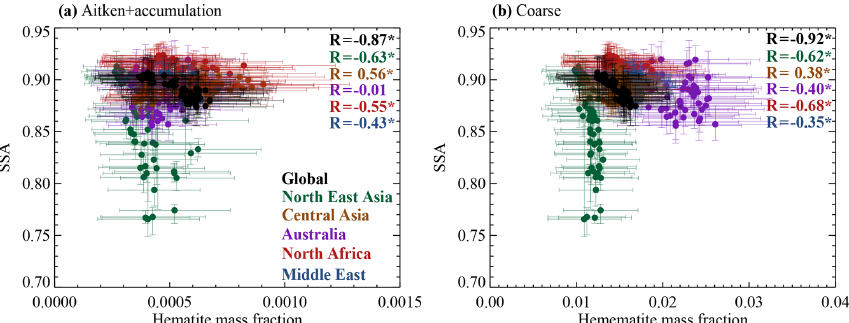
Figure 13. SSA at the 0.44–0.63µm band versus the mass fraction of hematite in Aitken plus accumulation (a) and coarse (b) modes for different sub-continental regions (the Middle East, northern Africa, Australia, Central Asia, and north-eastern Asia as indicated in the legend in color) and for global continents (in black). Simulations in CAM5 with C1999 for the baseline, perturbed iron-oxide mass fractions, DOD, and the imaginary complex refractive index are used for analysis. Each point represents an area-average annual mean for each simulation. Pixels identified as ocean mask and having DOD ≤ 0.5 · AOD for the land mask are removed for the regional analysis. Error bars indicate 1 standard deviation of the derived dust SSA and simulated hematite aerosol mass fraction in different modes. Also shown is the correlation coefficient between the derived dust SSA and hematite aerosol mass fraction. Stars indicate that the correlation is statistically significant at the 95% confidence level.